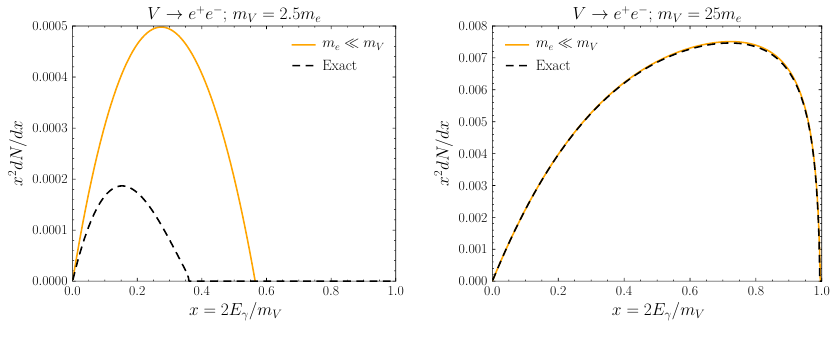
Figure 18: Comparison of the exact and approximate expressions in the V rest frame for two different choices of m V